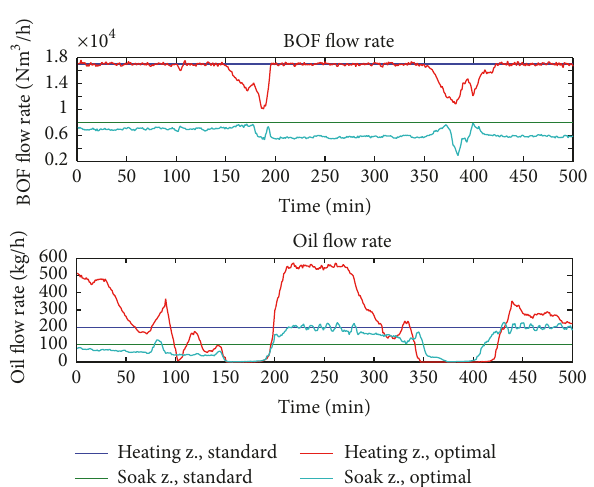
Figure 8: Normalized standard energy cost and optimal test energy cost found for actual reheating